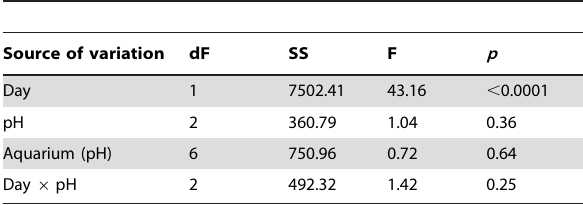
Table 2. Summary of ANOVA results of survivorship of larvae of Acropora digitifera